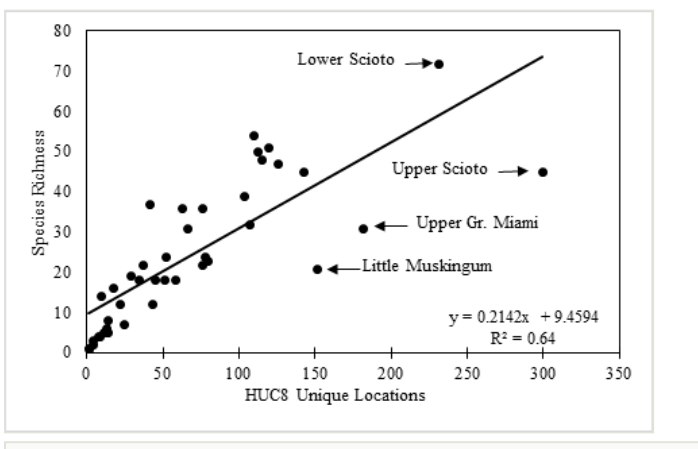
Figure 4. Stone fl y species richness vs. number of HUC8 unique locations. Simple linear regression equation and R provided. Names of HUC8s with greatest deviation from line-of-best- fi t provided.